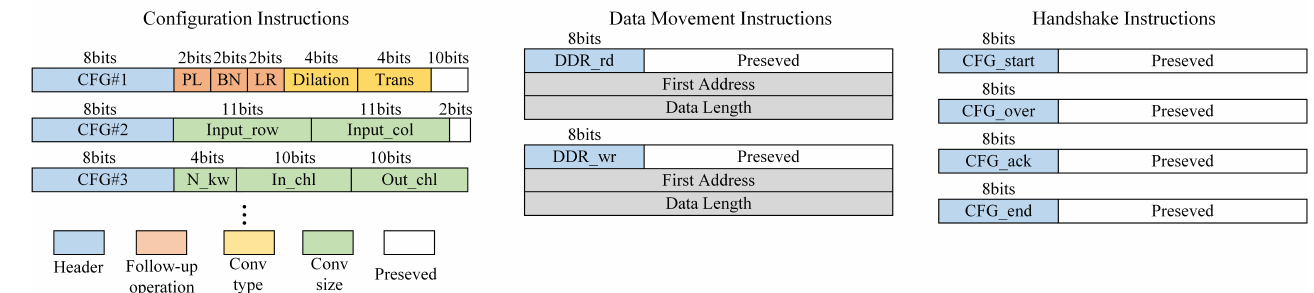
Figure 16. Instruction examples from the hardware instruction